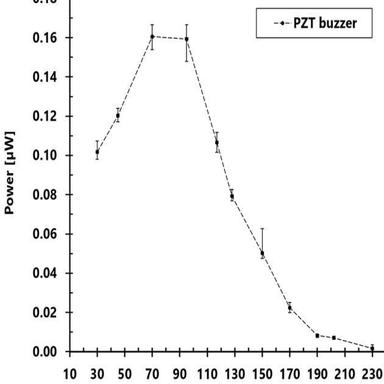
Output power of lead zirconate titanate (PZT) buzzer as a function of temperature. Data points are average peak power; error bars represent maximum and minimum values at given temperature point. (https://doi.org/10.6084/m9.figshare.12585023) CC BY 4.0 license].